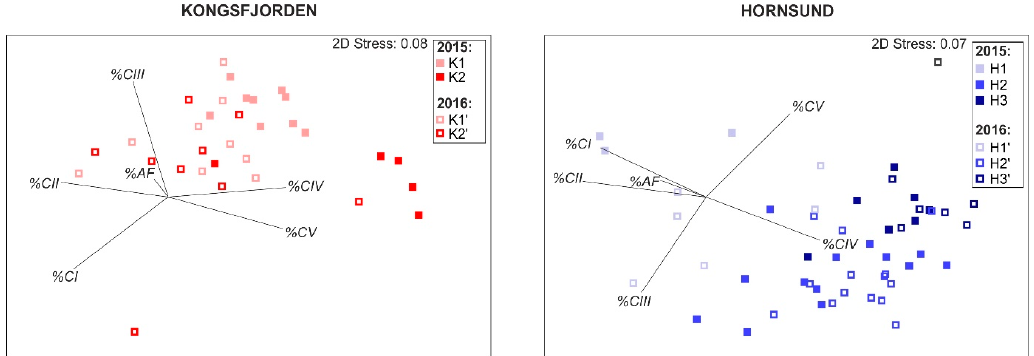
Figure 6. The non ‐ metric multi ‐ dimensional scaling (nMDS) of the Calanus copepodite structure in two Spitsbergen fjords: Kongsfjorden and Hornsund. Vectors indicate the direction of best correlating variables determined as a percentage of each copepodite stage. Their lengths correspond with the strength of the correlation. Water 2019 , 11 , x FOR PEER REVIEW